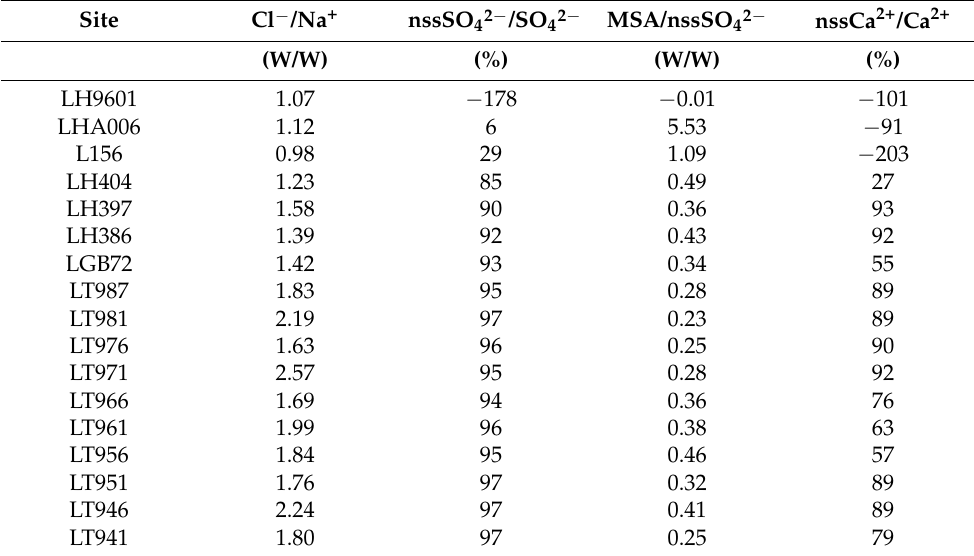
Table 5. Detailed values of Cl − /Na + , nssSO 42 − /SO 42 − , MSA/nssSO 42 − , and nssCa 2+ /Ca 2+ in the surface snow samples from coast to inland. Site Cl − /Na + nssSO 42 − /SO 42 − MSA/nssSO 42 − nssCa 2+ /Ca 2+ (W/W) (%) (W/W) (%) LH9601